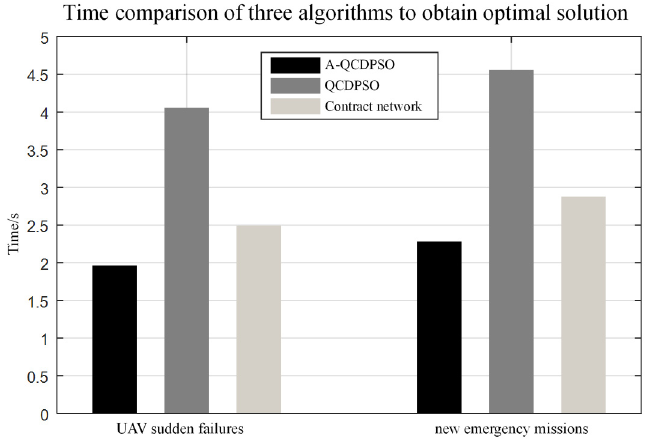
Figure 10. Time comparison of three algorithms to obtain an optimal solution.